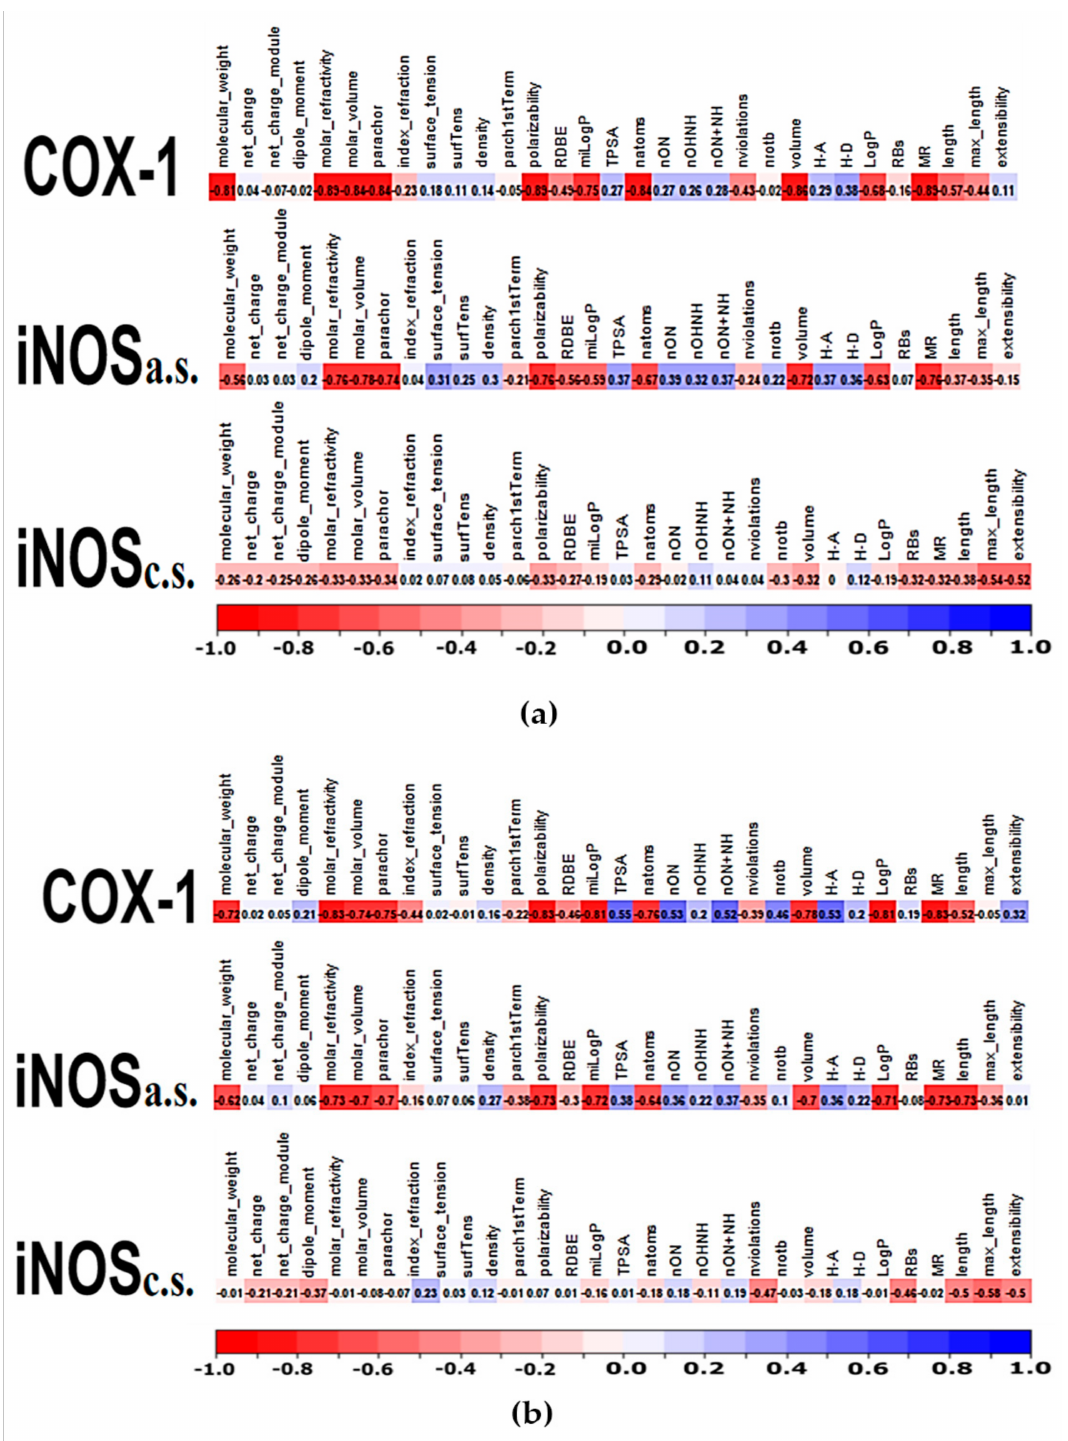
Figure 5. ( a ) Aroeira + Controls : Correlation vectors between different molecular descriptors from the aroeira compounds and their docking scores at each site. Negative correlations between the descriptors and the dockins scores (red) indicate attributes that improve the affinity. Positive cor- relations (blue) indicate attributes that draw back the affinity. No correlation (white) indicates no significant influence. ( b ) Aroeira : Correlation vectors between different molecular descriptors from the aroeira compounds and their docking scores at each site. Negative correlations between the descriptors and the dockins scores (red) indicate attributes that improve the affinity. Positive cor- relations (blue) indicate attributes that draw back the affinity. No correlation (white) indicates no significant